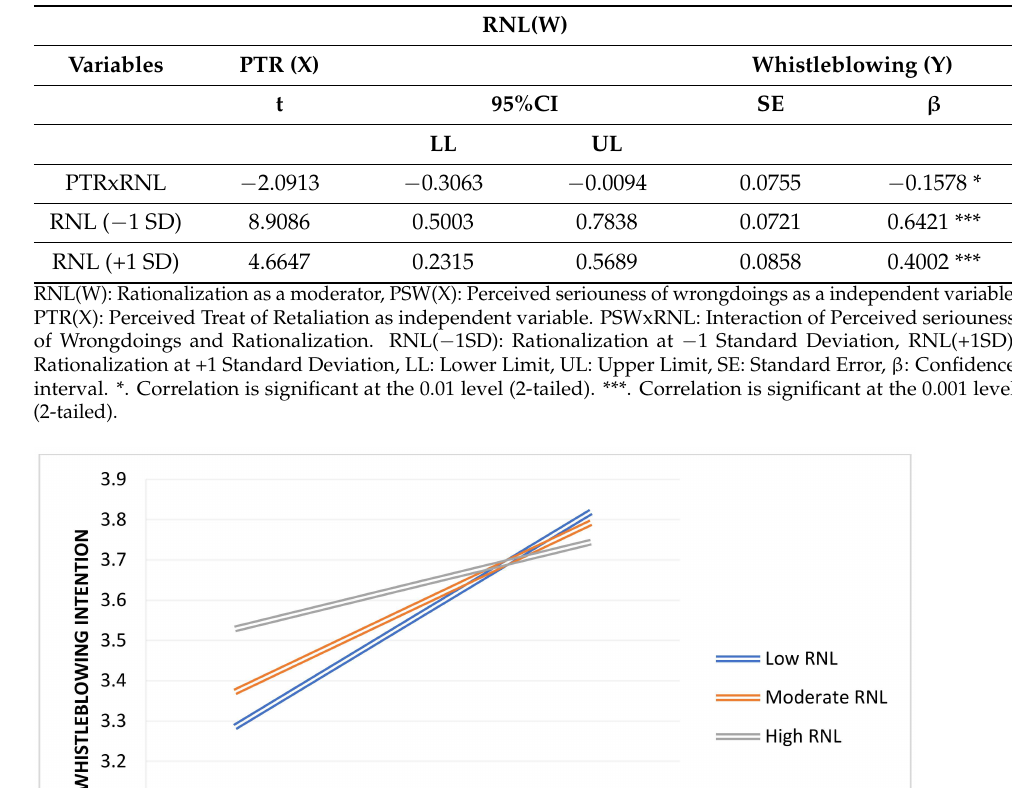
Table 7. Moderation Analysis.